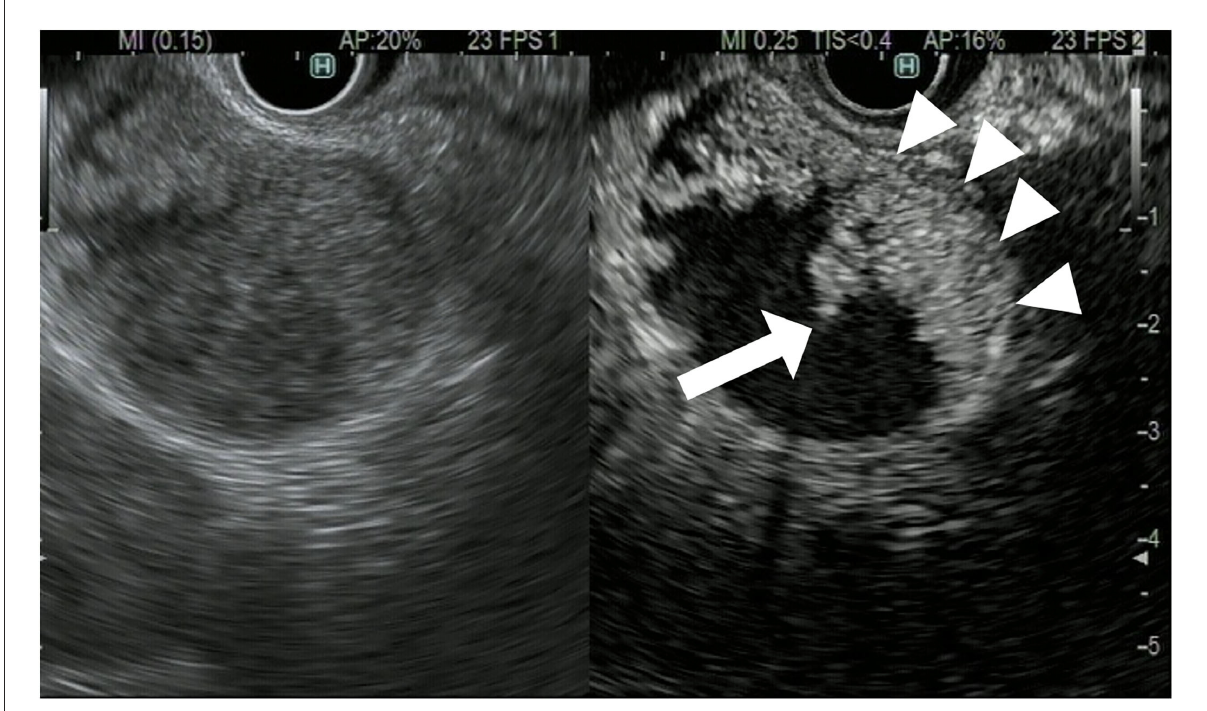
FIGURE10 Contrast-enhanced harmonic EUS for staging of gallbladder carcinoma. T3 gallbladder carcinoma: heterogenous hyperenhancing tumor (arrow) in the gallbladder without disrupted hyperenhancement in the outer layer